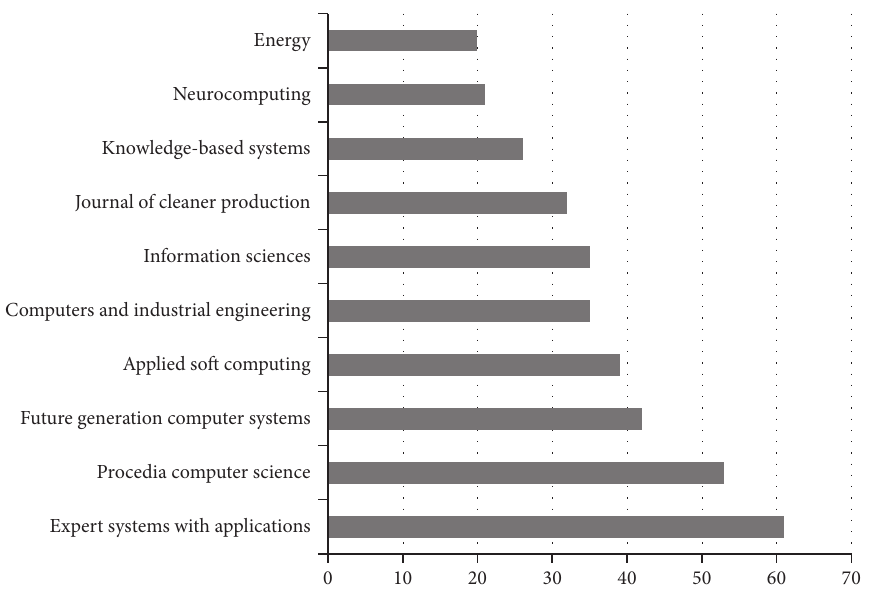
Figure 10: Publication title along with the number of papers.